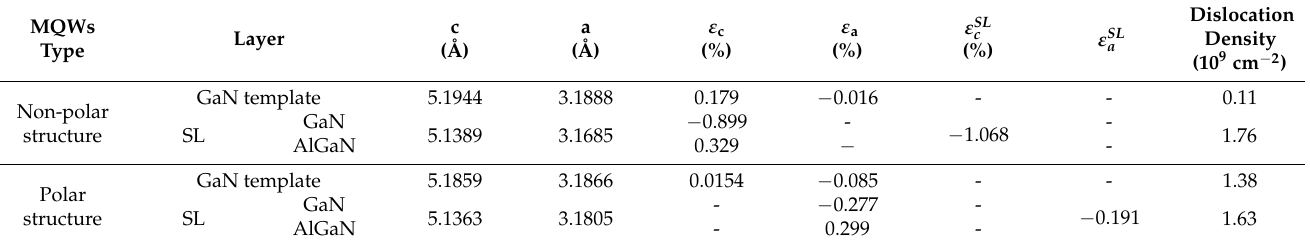
Table 1. Structural characteristics of the non-polar and polar GaN/AlGaN structures on GaN substrates: lattice parameters, in-plane strains, and dislocation densities of the GaN templates and the SLs. Strains in GaN QWs and AlGaN QBs ( ε c and ε a ) are determined comparatively to bulk GaN, or a hypothetical AlGaN layer in SL, respectively. Strains in SLs ( ε SL c and ε SL a ) are determined comparatively to substrate.